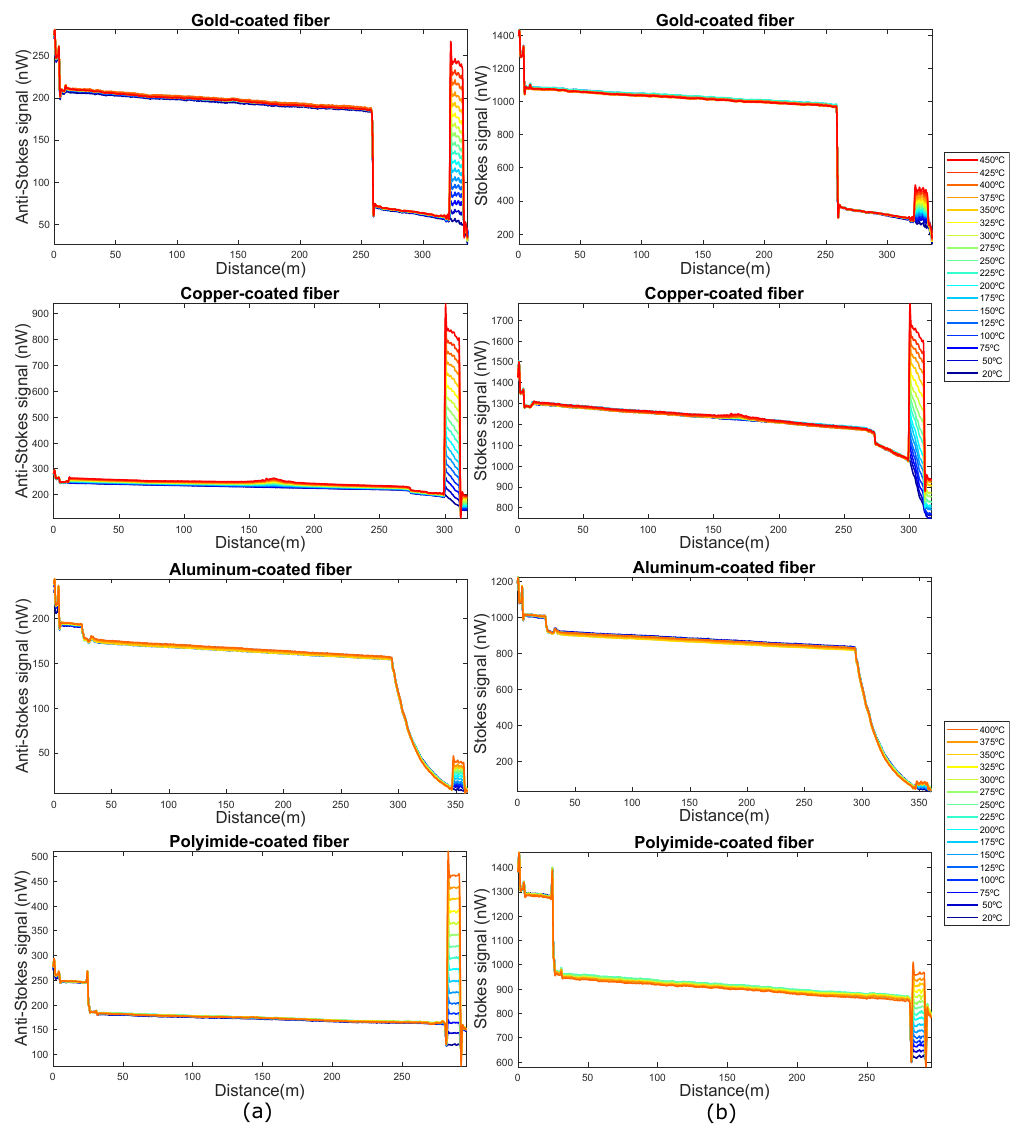
Figure 3. ( a ) Anti-Stokes and ( b ) Stokes signals obtained for gold-coated, copper-coated, aluminum-coated and polyimide/carbon-coated fibers (from top to bottom respectively) in the entire fibers under test